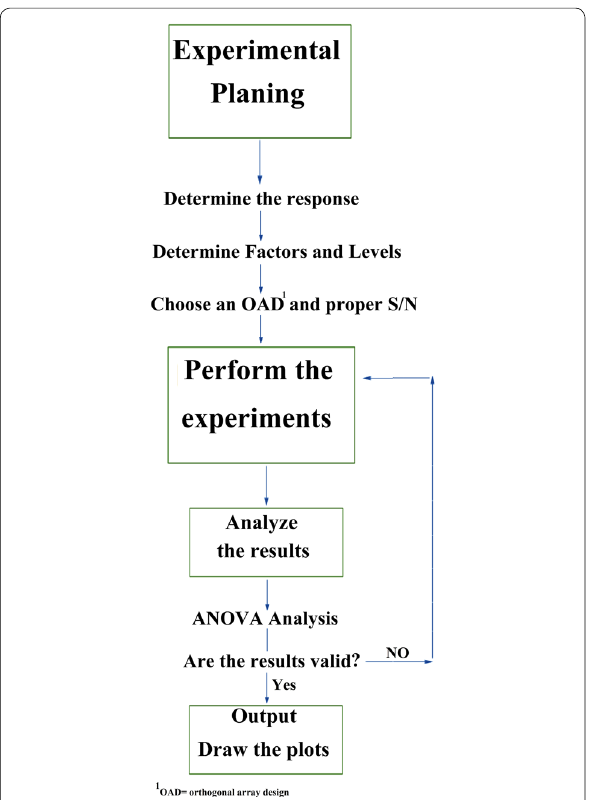
Fig. 1 Procedure of Taguchi design method